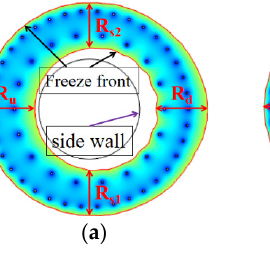
Figure 8. Schematic presentation of characteristic parameters of effective frozen wall thickness. ( a ) Initial stage of closure; ( b ) middle stage I of closure; ( c ) middle stage II of closure; ( d ) last stage of